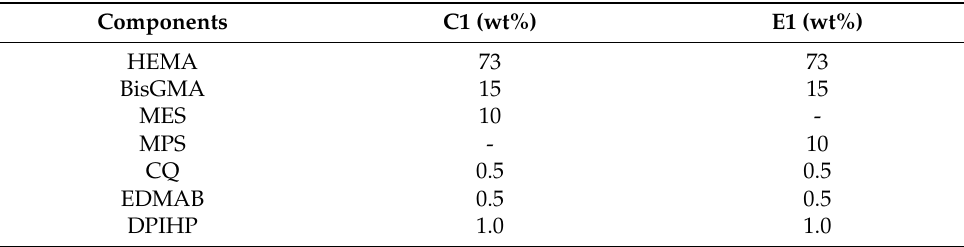
Table 3. Chemical composition of the